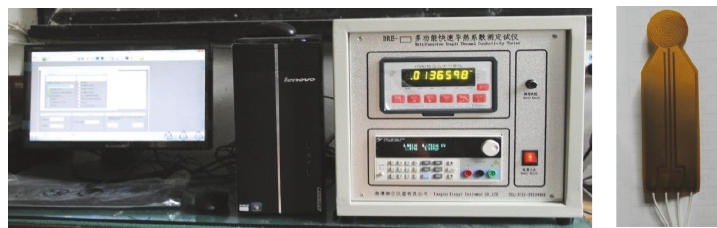
Figure 11: DRE-III heat conductivity coefficient tester and measuring probe.